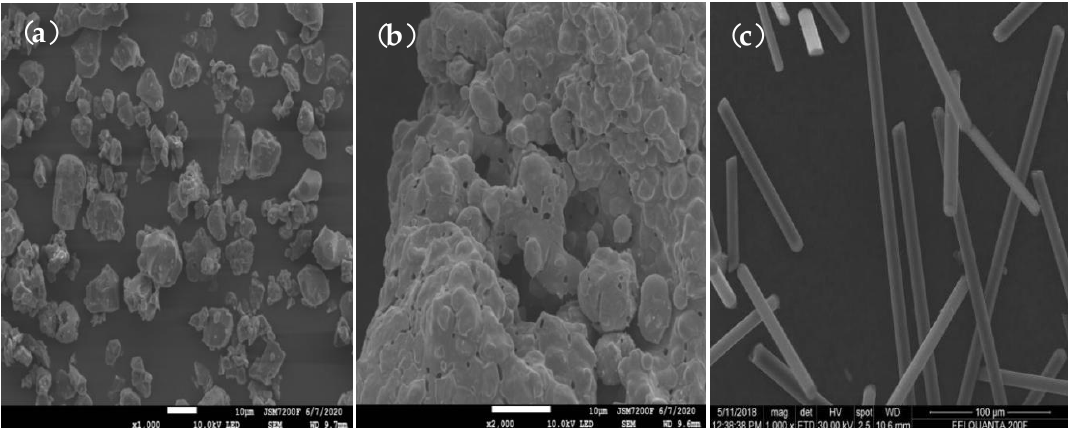
Figure 3. SEM images. ( a ) CP. ( b ) AIN. ( c ) CF.